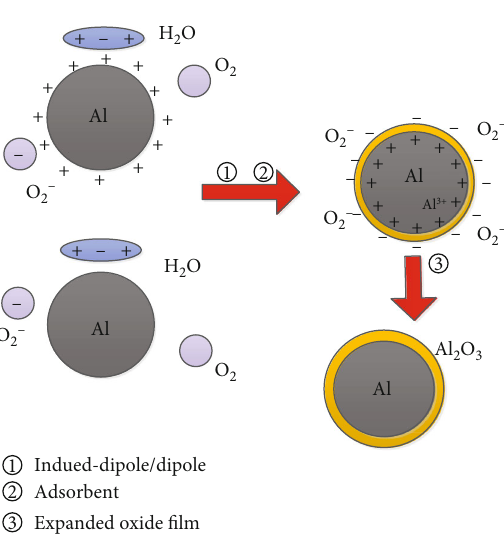
Figure 8: Oxidation mechanism of aluminum powder at room